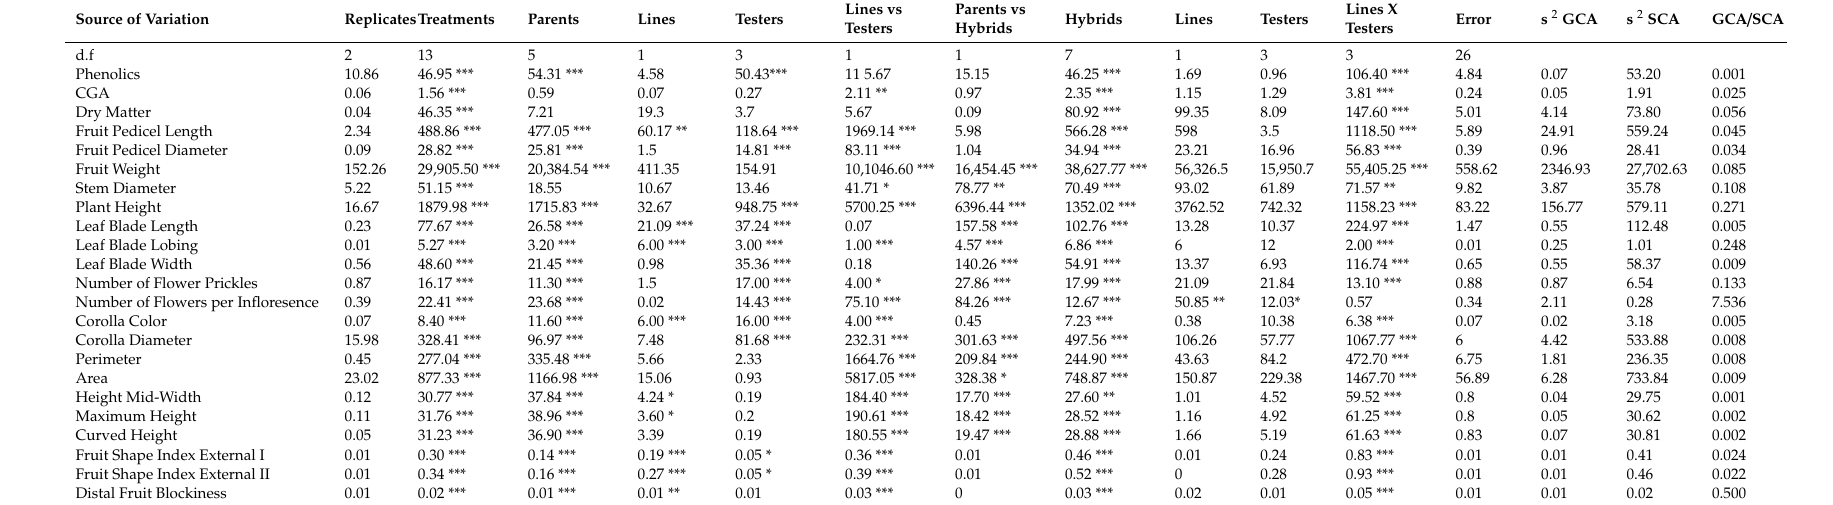
Table 3. Analysis of variance for general combining ability (GCA) and specific combining ability (SCA) for the descriptors studied for the characterization. Source of